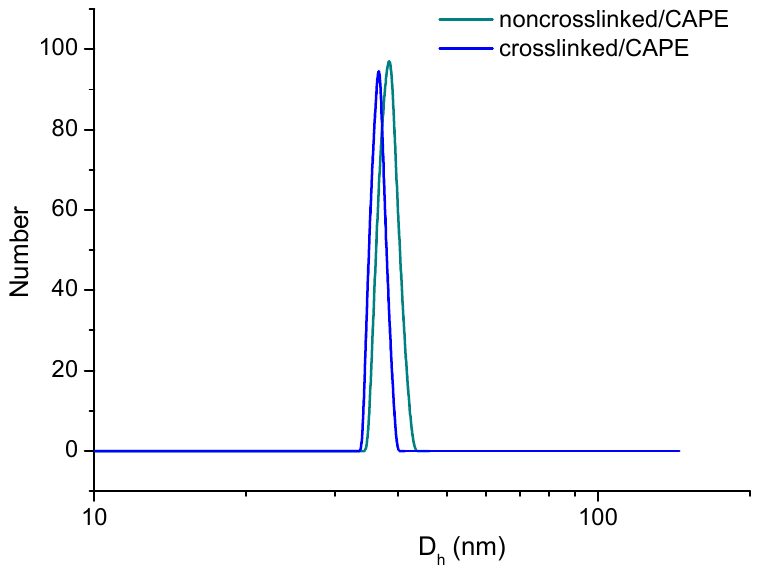
Figure 3. Size distribution plots of CAPE-loaded non-crosslinked and crosslinked micelles, based on PEO 113 -b-PCL 35 -b-PEO 113 and PAA 13 -b-PCL 35 -b-PAA 13 amphiphilic triblock copolymers, in PBS at 37 °C.